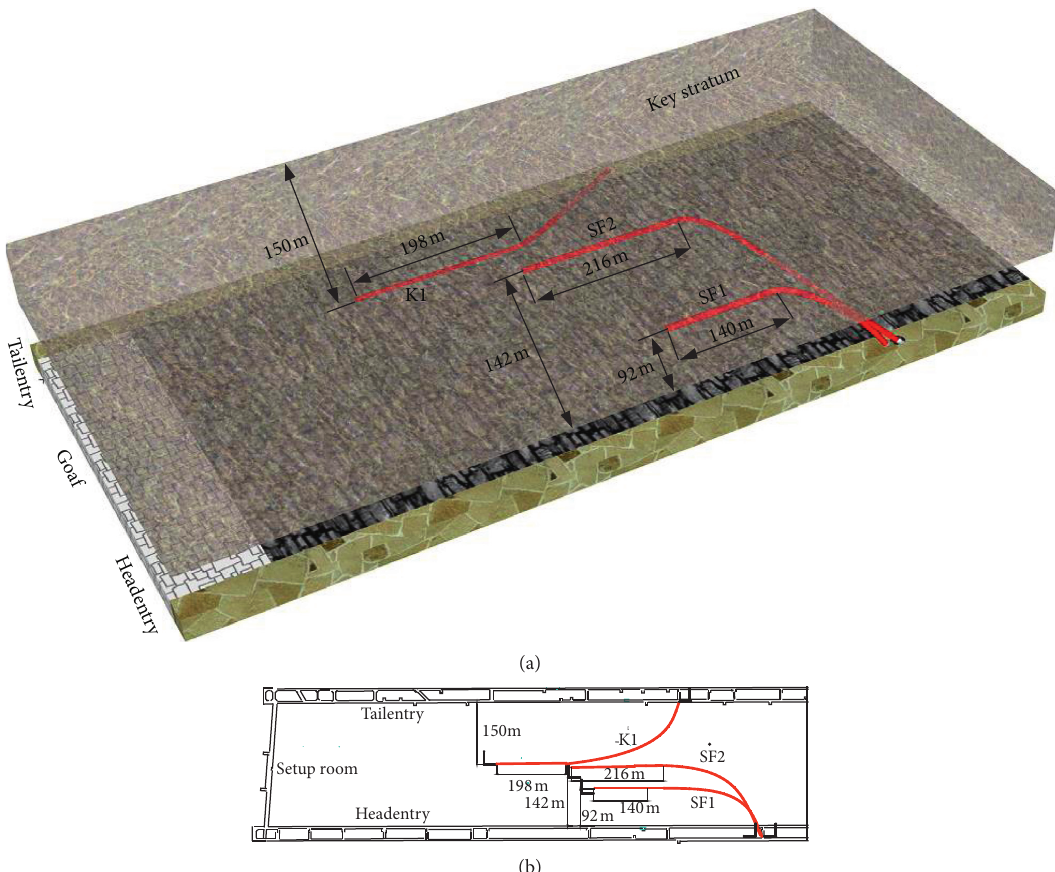
Figure 10: Positions and parameters of three boreholes: (a) stereogram; (b)